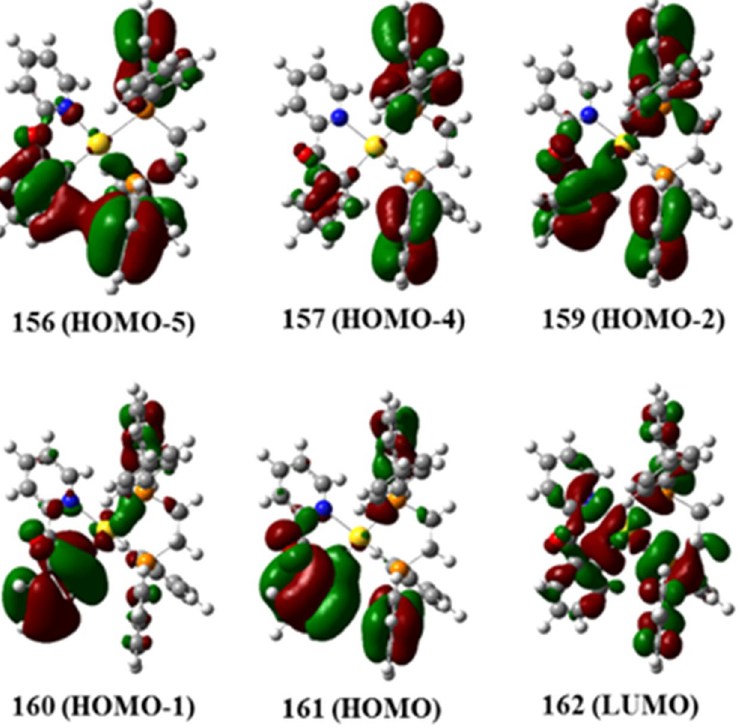
Figure 4. LUMO, HOMO, HOMO-1, HOMO-2, HOMO-4, and HOMO-5 electronic density maps for 6 . Calculated on B3LYP, SDD on Au and 6–31 G(d,p) on